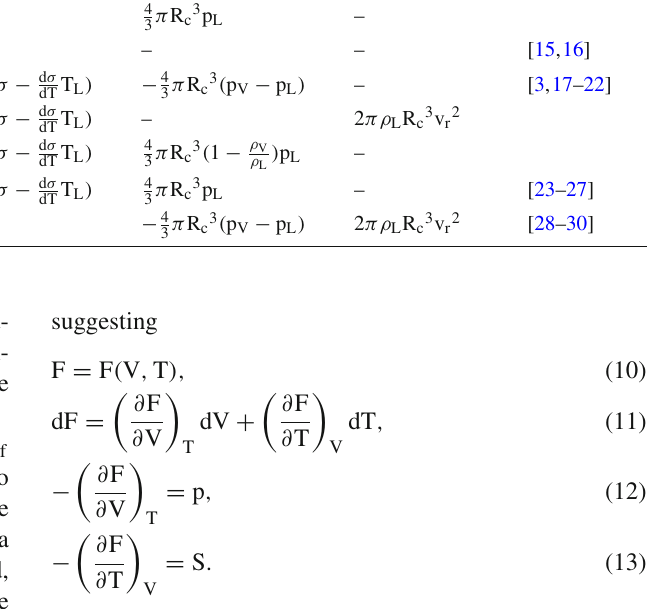
Table 1 Terms in the E c equation proposed by different authors